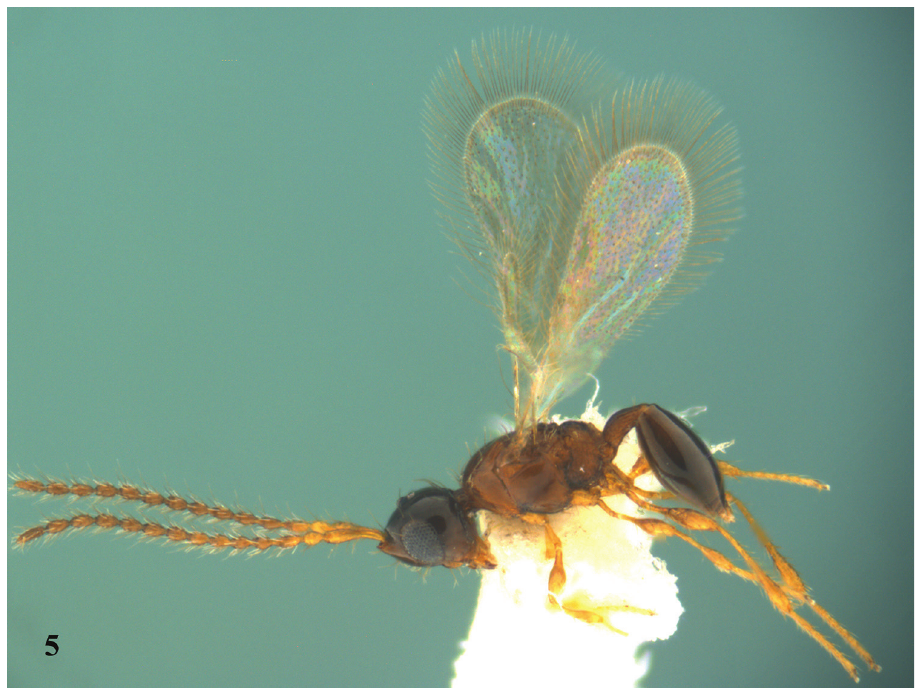
Figure 5. Calogalesus sinicus sp. n., ♂ , paratype, habitus, lateral.